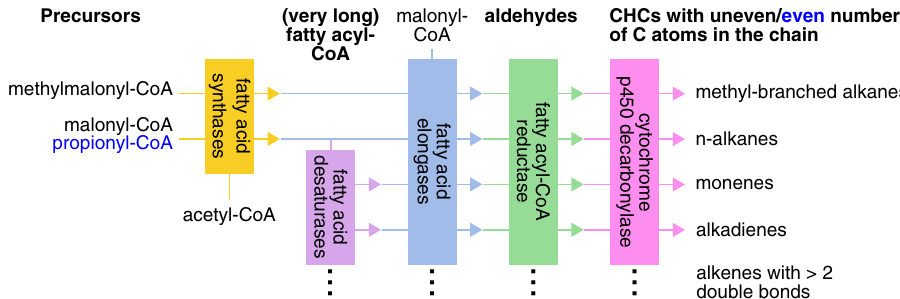
Fig. 1 Schematic overview of the main steps of cuticular hydrocarbon biosynthesis. The pathway starts with a fatty acid synthase (FAS) that binds acetyl- coenzyme A (CoA) with malonyl-CoA units. The resulting acyl-CoA (with an even number of carbon atoms) is repeatedly elongated by a FAS which binds acyl-CoA with malonyl-CoA. During each elongation step, the chain length of the fatty acyl-CoA increases by two carbon atoms. Fatty acyl-CoA chains with an uneven number of carbon atoms are thought to arise from substituting malonyl-CoA with propionyl-CoA during the elongation step. The consecutive elongation of the fatty acyl-CoA chain by FAS results in long chain fatty acyl-CoAs. Additional elongation of these fatty acyl-CoA chains to very-long fatty acyl-CoA requires the action of fatty acid elongases that add additional malonyl-CoA molecules to the long chain fatty acyl-CoA. These are reduced into aldehydes by fatty acyl-CoA reductases. Before the latter step, double bonds can be inserted in the (very-)long chain fatty acyl-CoAs by fatty acid desaturases, resulting in the biosynthesis of unsaturated hydrocarbons with a different number of double bonds (alkenes, alkadienes). The biosynthesis of methyl-branched alkanes is thought to depend on the action of a specialized fatty acid synthase that incorporates methylmalonyl-CoA instead of malony-CoA into the chain at speci fi c positions during the chain elongation. The last step of CHC biosynthesis is the oxidative decarbonylation of aldehydes leading to hydrocarbons (with the loss of one carbon atom) by a cytochrome p450. Based on 2,5 – 9